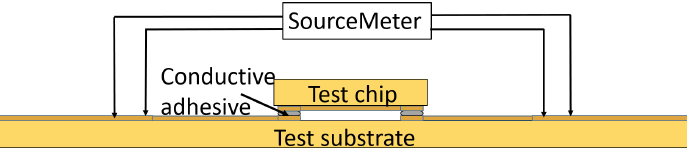
Figure 7. Schematic of the four point resistance measurement for the characterisation of electrical performance of the conductive adhesive